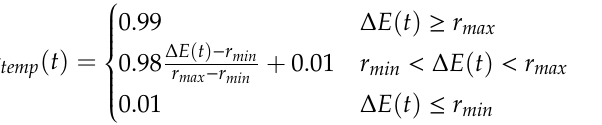
temporal weights and the subband weights in Figure